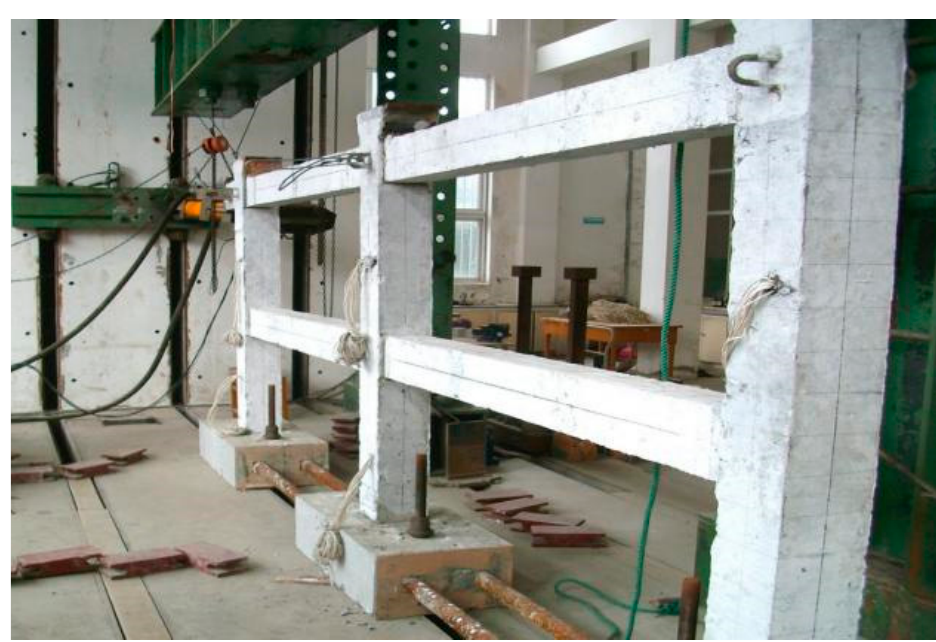
Figure 3. Accomplished test frame.